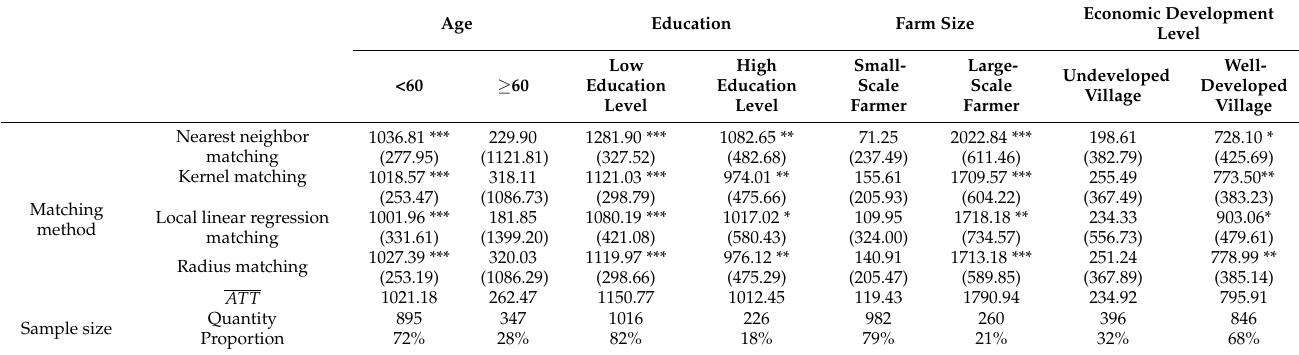
Table 7. Analysis of heterogeneity based on family